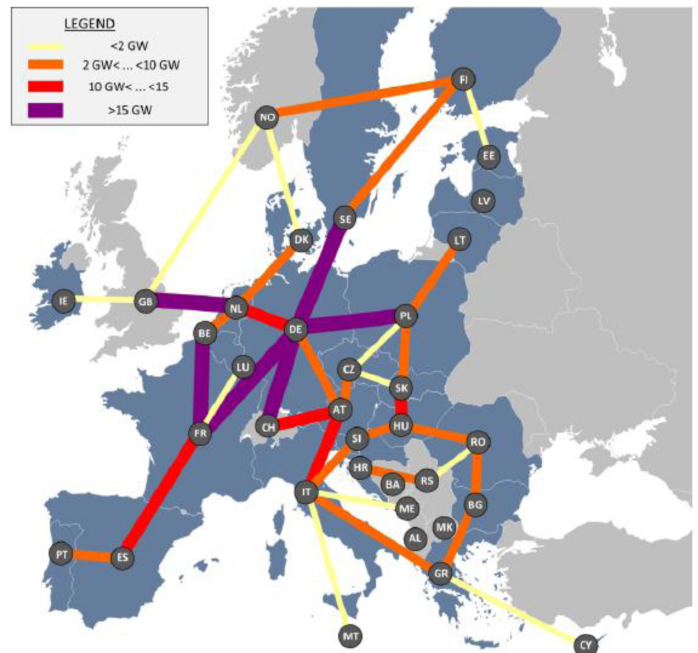
Figure 6. Additional electricity infrastructure in the reference scenario compared to current situation.